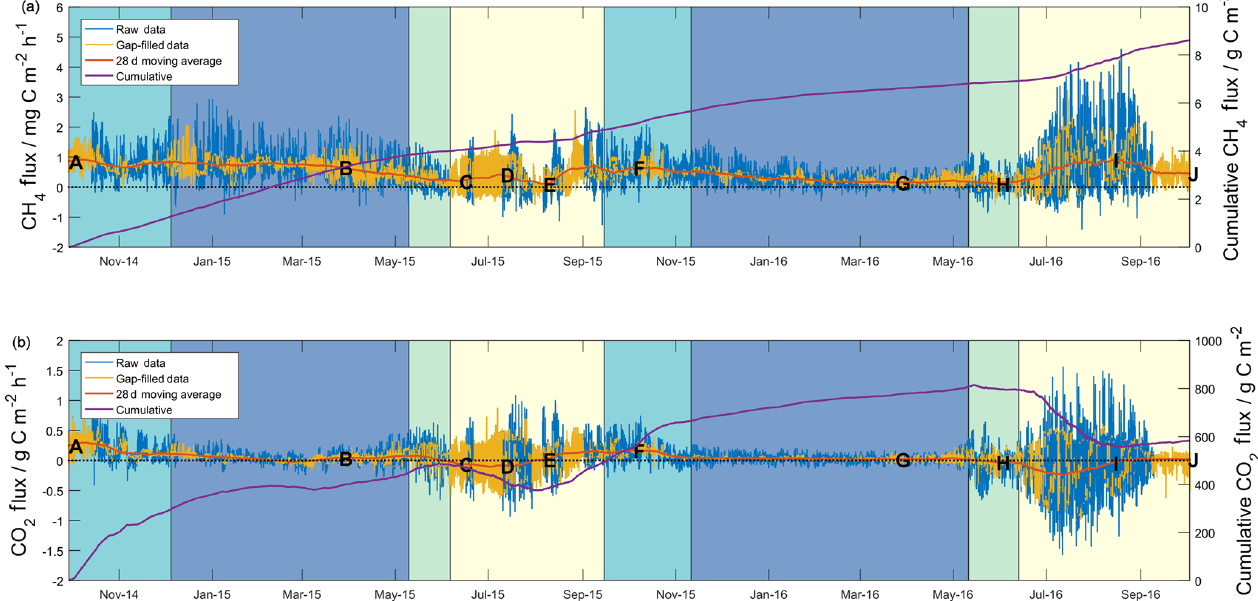
Figure 1. Half-hourly measured (blue lines) and gap filled (yellow lines), and cumulative flux data (purple lines) for methane (a) and carbon dioxide (b) . The 28d centred moving averages (red lines) have been included based on half-hourly flux data. Shading shows seasons (as defined in the text) for both years beginning with freezing (turquoise), then frozen (blue), thawing (green) and active (yellow). Lettering corresponds to that defined in the caption of Fig. 2. Table 1. Overview of methane fluxes split according to season. Values in parentheses in cumulative columns are percentages of the total for that year. Daily differences are the differences in mean daily fluxes for that season between the two years, with p statistics from Student’s two-sample t test giving the significance with which the null hypothesis (values come from distributions with same mean) can be rejected. Year 1 Year 2 Daily